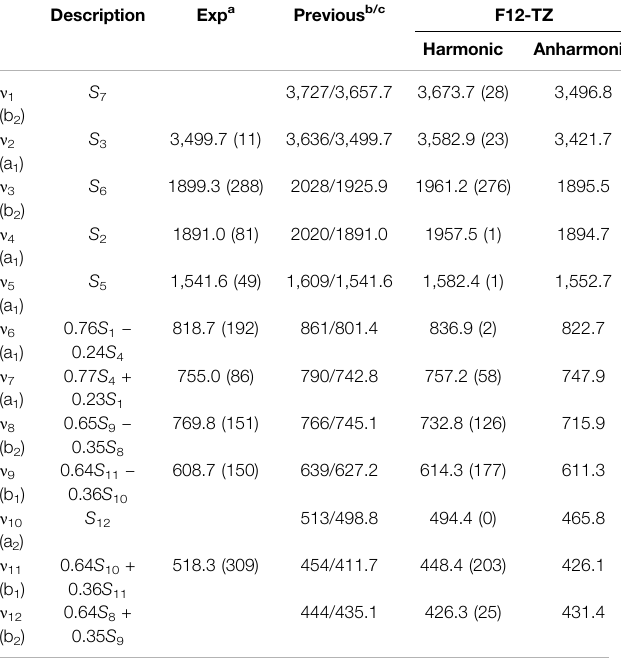
TABLE 11 | Vibrational Frequencies (in cm − 1 ) of AlH 2 NH 2 with MP2/aug-cc-pVTZ Intensities in Parentheses (in